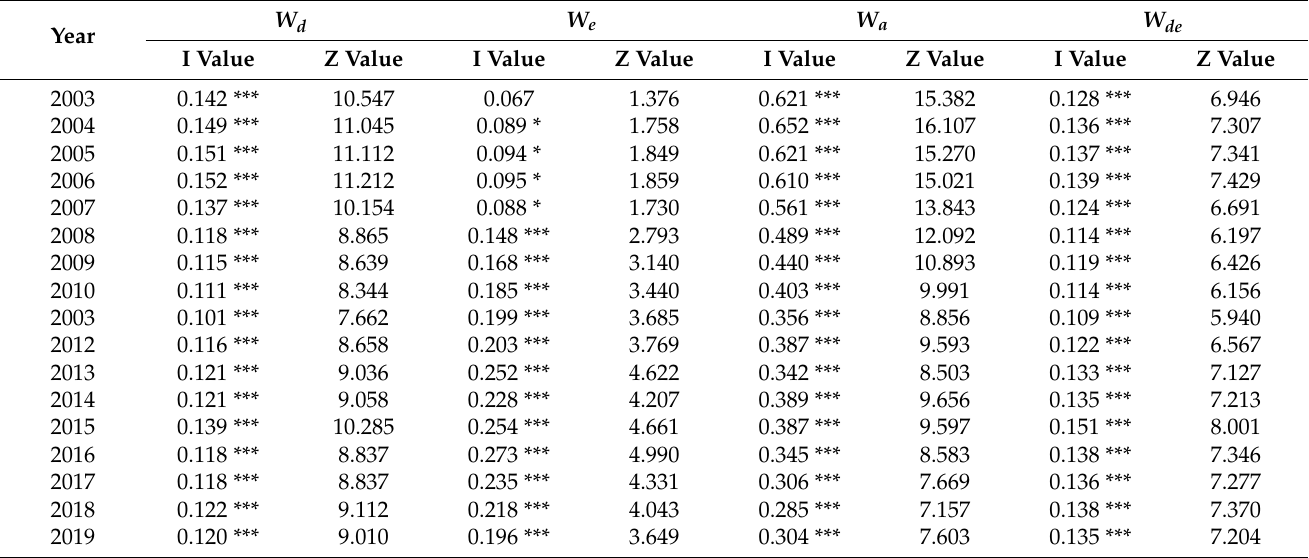
Table 3. Moran Index of ECP in the YRB from 2003 to